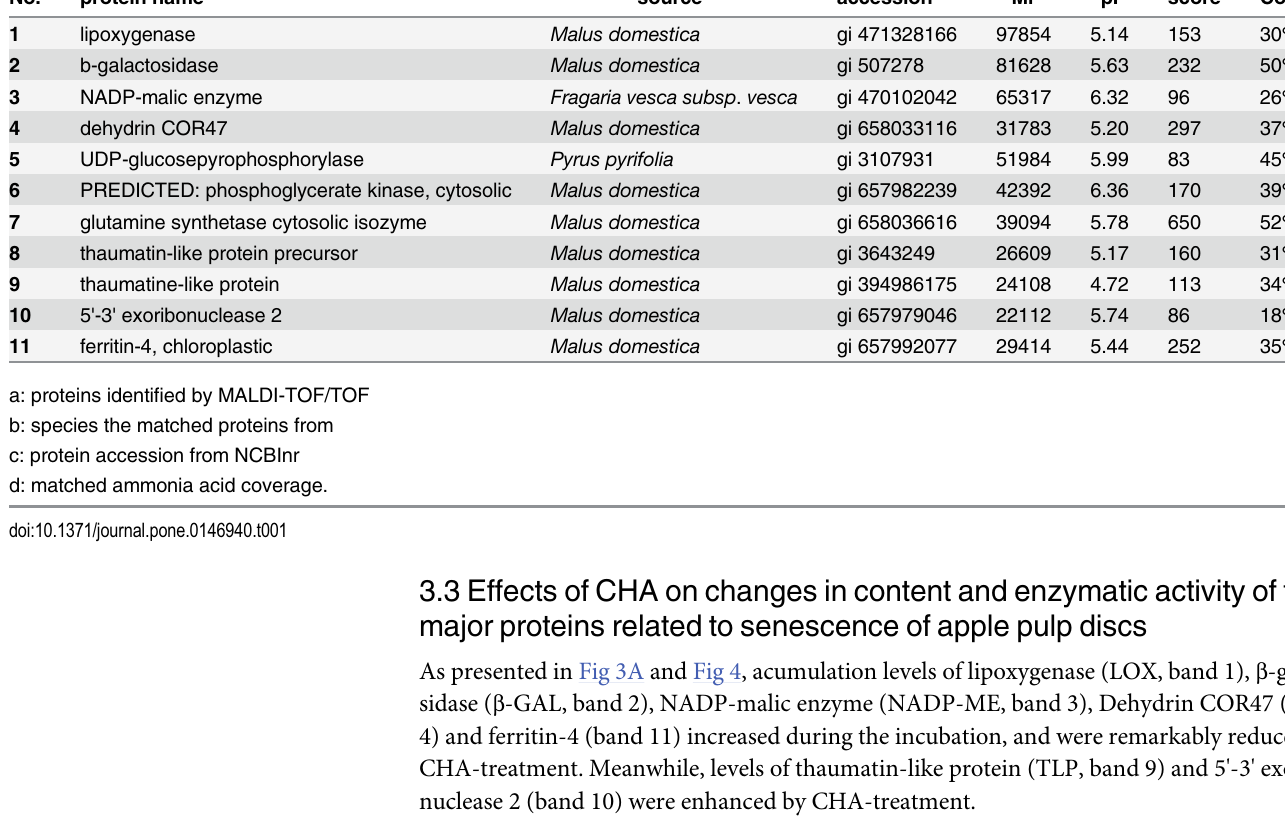
Table 2. Peptide sequences identified from the apple pulp by mass spectrometry and their localization within matched